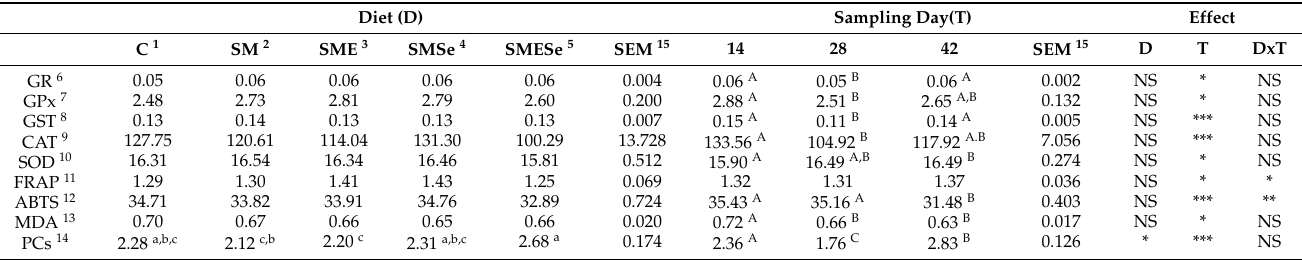
Means with different superscripts in each row among the dietary treatments (a, b, c) and the three-sampling times (A, B, C) for each parameter differ significantly ( p ≤ 0.05). 1 C = control; 2 SM = sesame meal; 3 SME = sesame meal +60 mg of VitE/kg concentrate; 4 SMSe = sesame meal